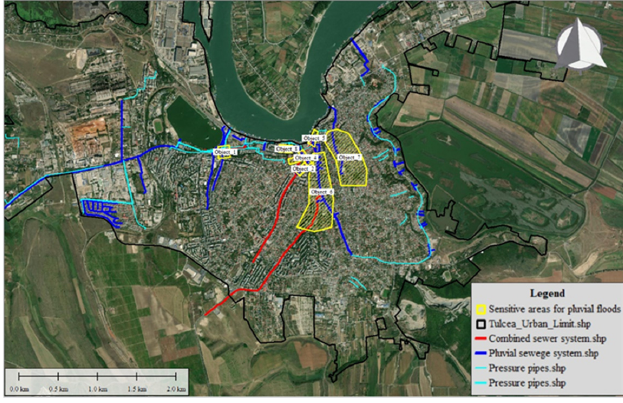
Figure 4. The main collectors of the sewage system (wastewater in orange, pluvial water in blue and green, and combined system in red).